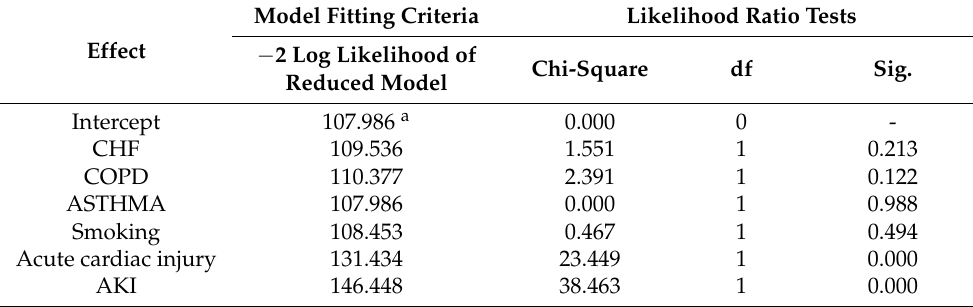
Table 4. Likelihood ratio tests.